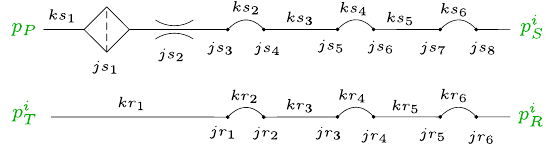
Figure 9: Considered supply and return line loss